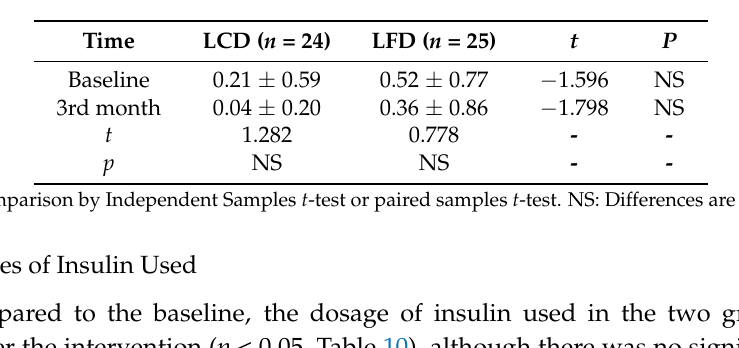
Table 10. Comparison of insulin dose (insulin unit, IU) between the two groups. Times LCD ( n = 7) LFD ( n = 13) t P Baseline 31.14 ± 16.38 29.00 ± 12.27 0.332 NS 3rd month 28.29 ± 13.74 26.62 ± 11.20 0.294 NS t 2.765 3.023